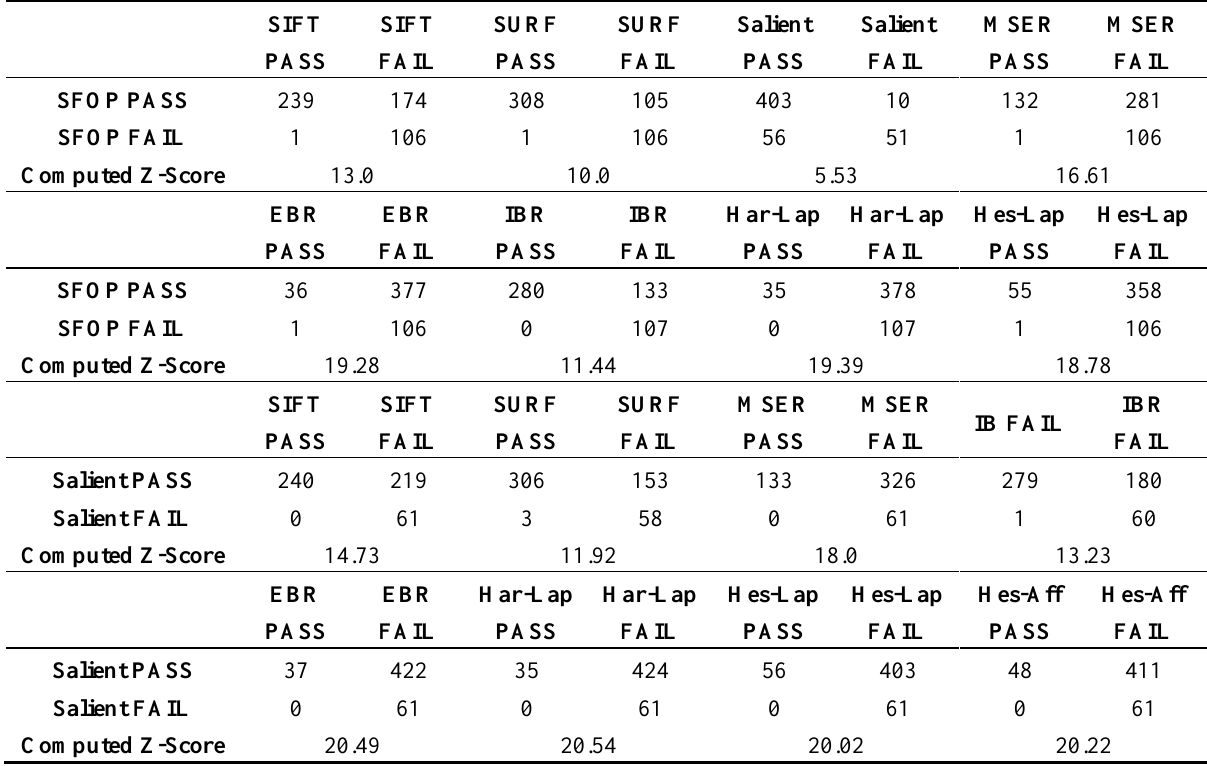
Table 1. McNemar’s test results for SFOP and Salient detector with other detectors.